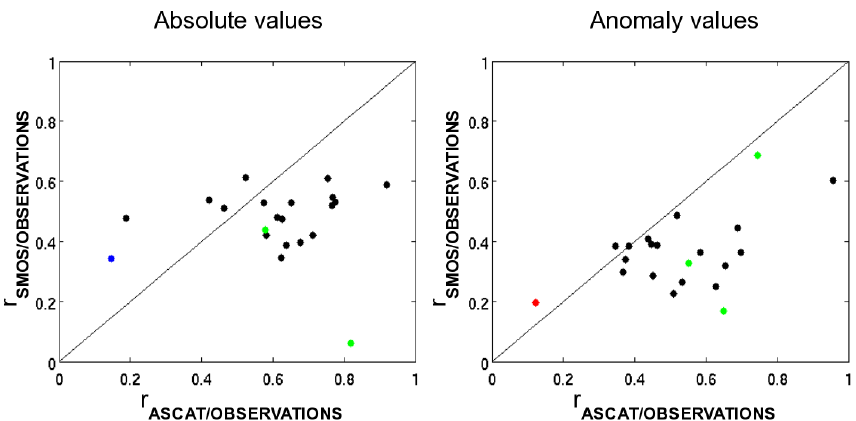
Fig. 3. SMOS-L2 vs. ASCAT SSM (left panel) absolute and (right panel) anomaly correlation coefficients with the SMOSMANIA in situ observations for each SMOSMANIA station. Black dots represent significant SSM correlations for both SMOS and ASCAT. Green dots represent significant SSM correlations for ASCAT, only. The blue dot indicates a significant SSM correlation for SMOS, only. The red dot corresponds to the MTM station, presenting no significant correlation (p-value > 0.05) for either SMOS or ASCAT.